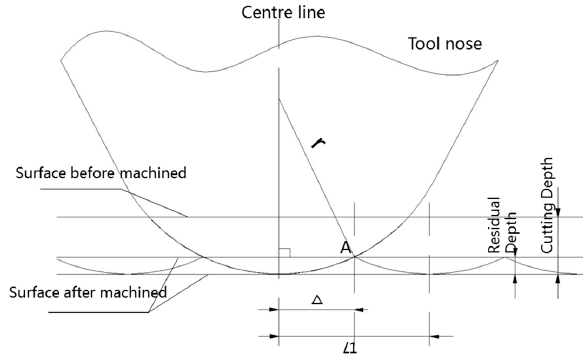
Figure 5. Geometrical model of the surface topography machined by SPDT.